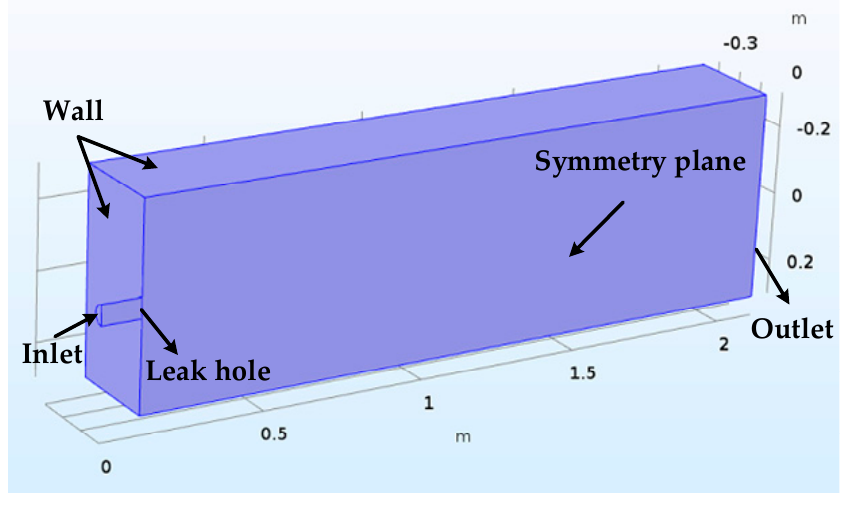
Figure 1. The flow field model.